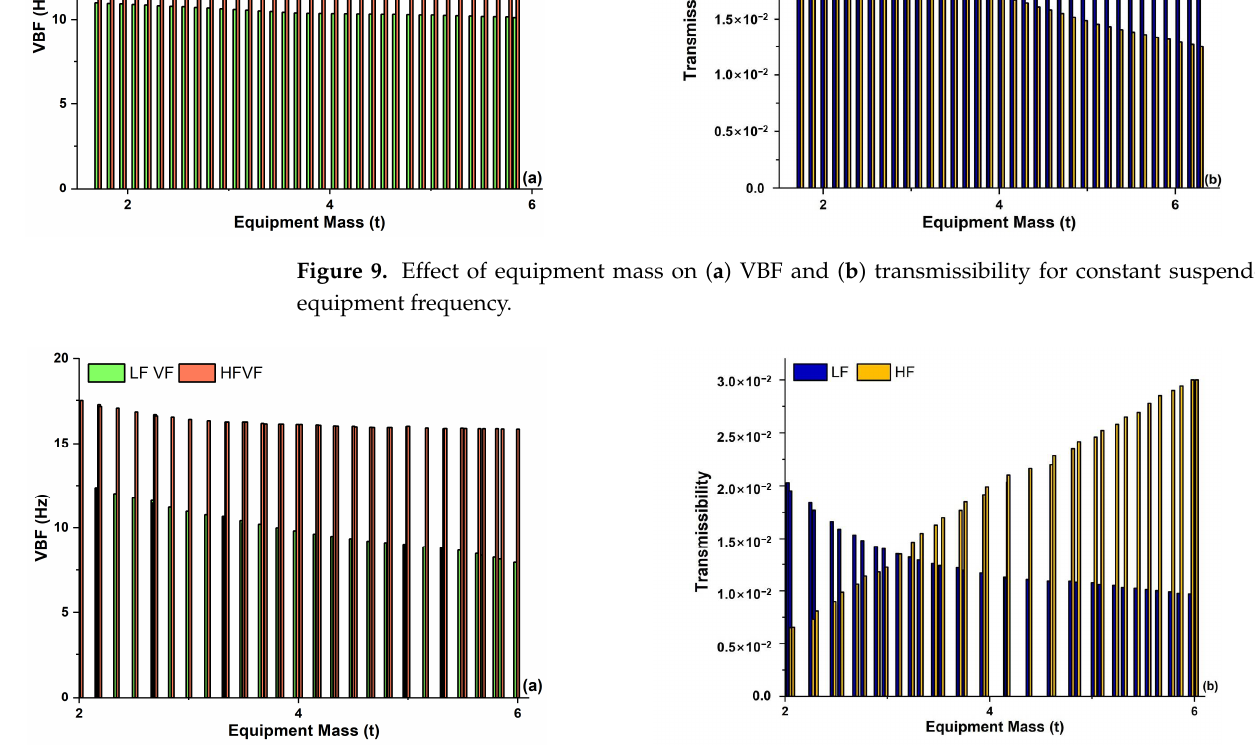
Figure 10. Effect of equipment mass on ( a ) VBF and ( b ) transmissibility for constant suspended equipment stiffness.